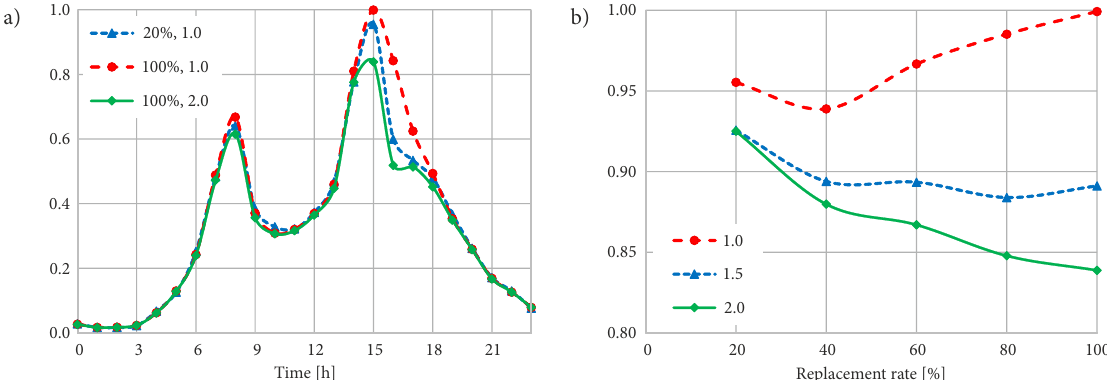
Figure 7. AT utilisation rates: a – hourly averages for selected simulation cases; b – peak-hour averages